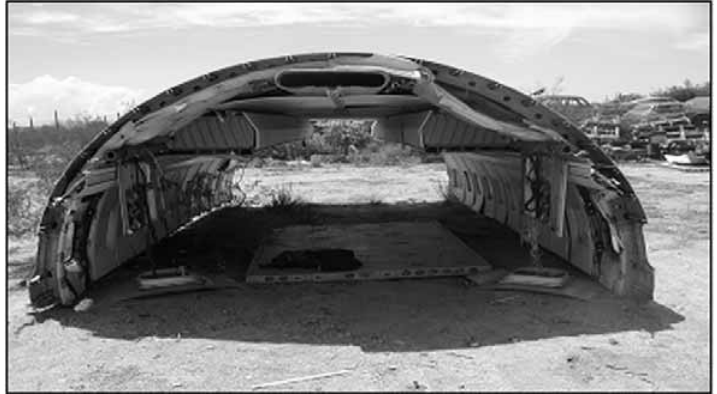
Fig. 6. A Boeing 737–100 fuselage section used for pre-prototype field tests.